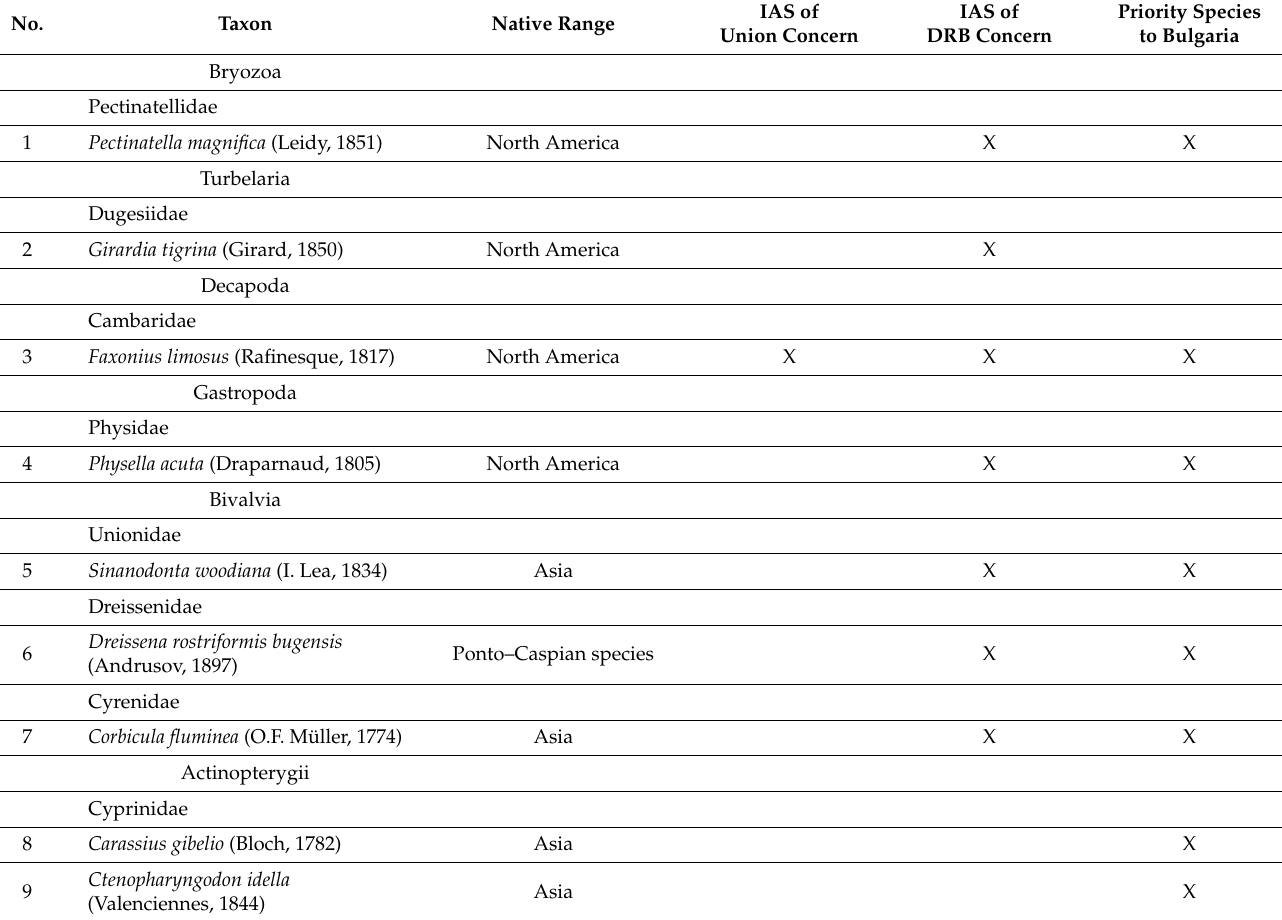
Table 1. List of invasive alien species (IAS) of benthic macroinvertebrates and fish recorded in the Bulgarian sector of the Danube River and adjacent water bodies during JDS4 (2019). X—indicates the status of the species according to the following categories: invasive alien species (IAS) of Union concern, IAS of Danube River Basin (DRB) concern and priority species to